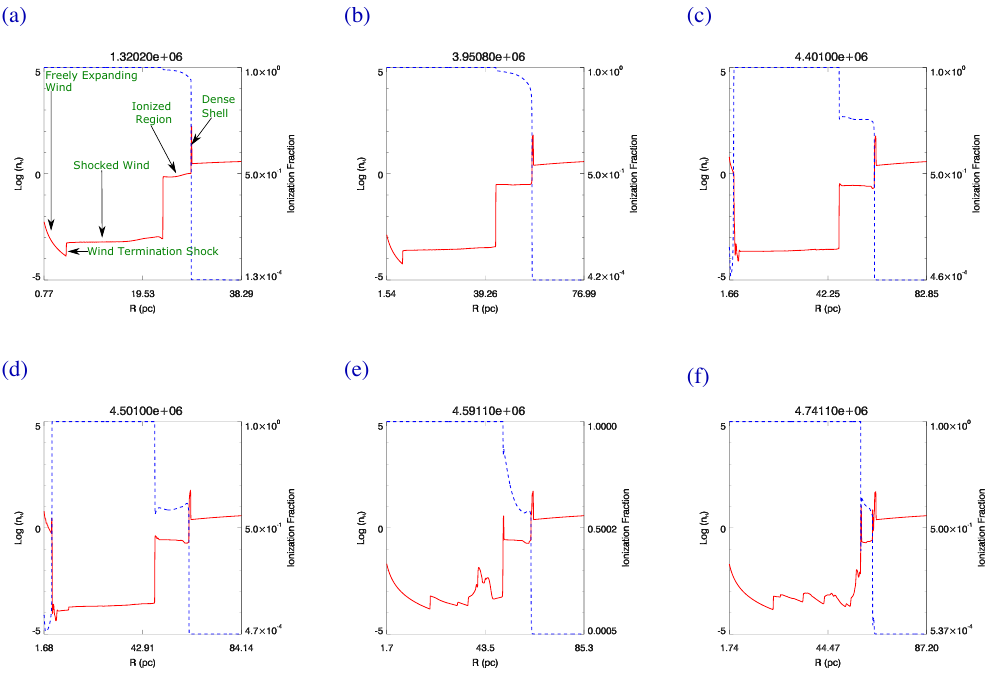
Figure 1. The number density (red line) and ionization fraction (blue line) at various times, from the spherically symmetric simulation. The left scale in each panel is the logarithm of the number density n H , defined as n H = ρ / ( 1.67 × 10 − 24 ) where ρ is the gas density. The right hand side is the ionization fraction, stretching from a value close to zero (almost neutral) to 1 (fully ionized). The stellar evolution time (age of the star) in years is given at the top. Panels ( a , b ) refer to the MS phase, panels ( c , d ) to the RSG phase, and panel ( e , f ) to the W-R